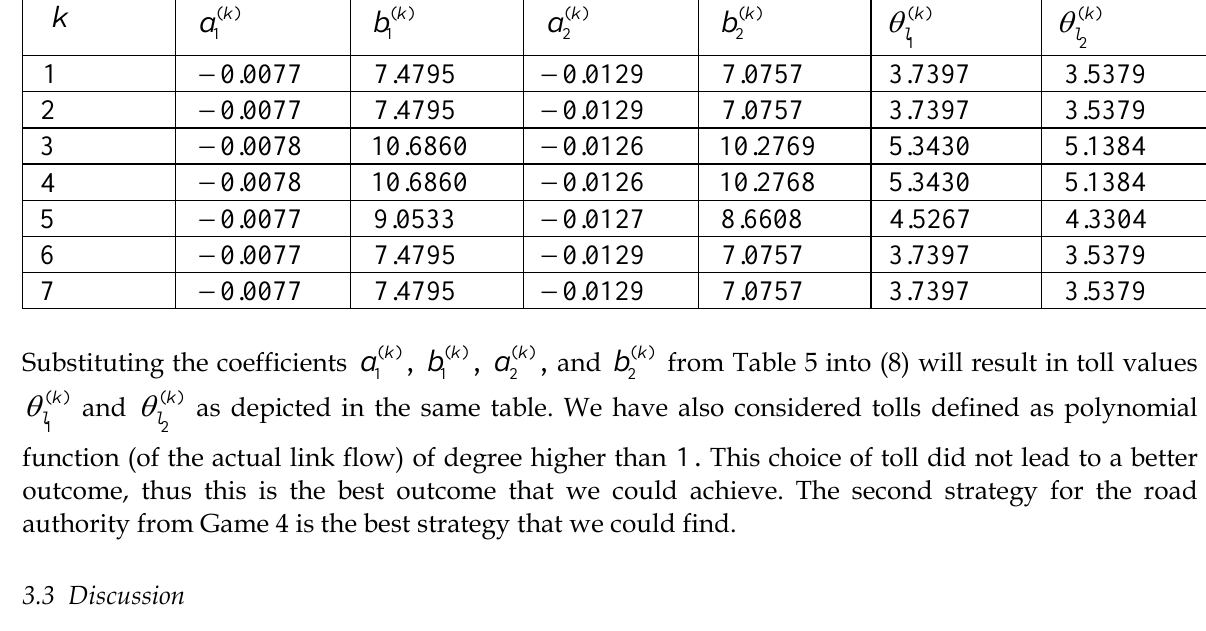
Table 5. Optimal toll function coefficients and resulting tolls [€]: Total toll revenue